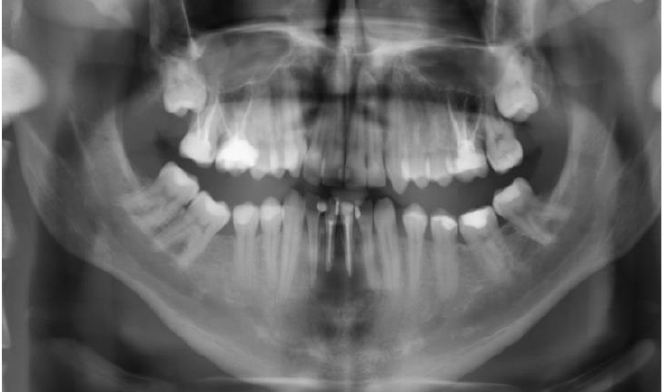
Figure 5. Immediate postoperative OPG showing the root canal filled teeth 31 and 41 following successful cystectomy and apicectomy.